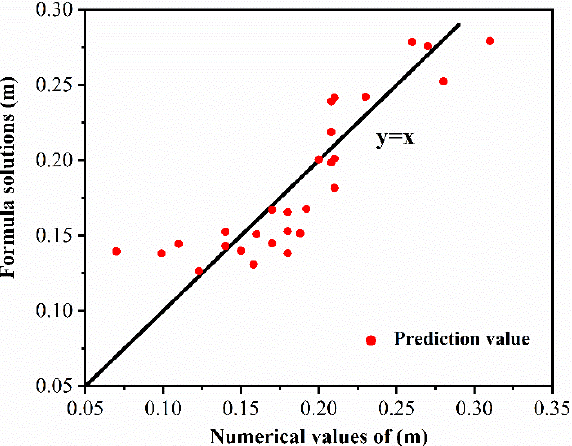
Figure 13. Comparison between the numerical values and values derived by the prediction formula for propagation wave amplitude.